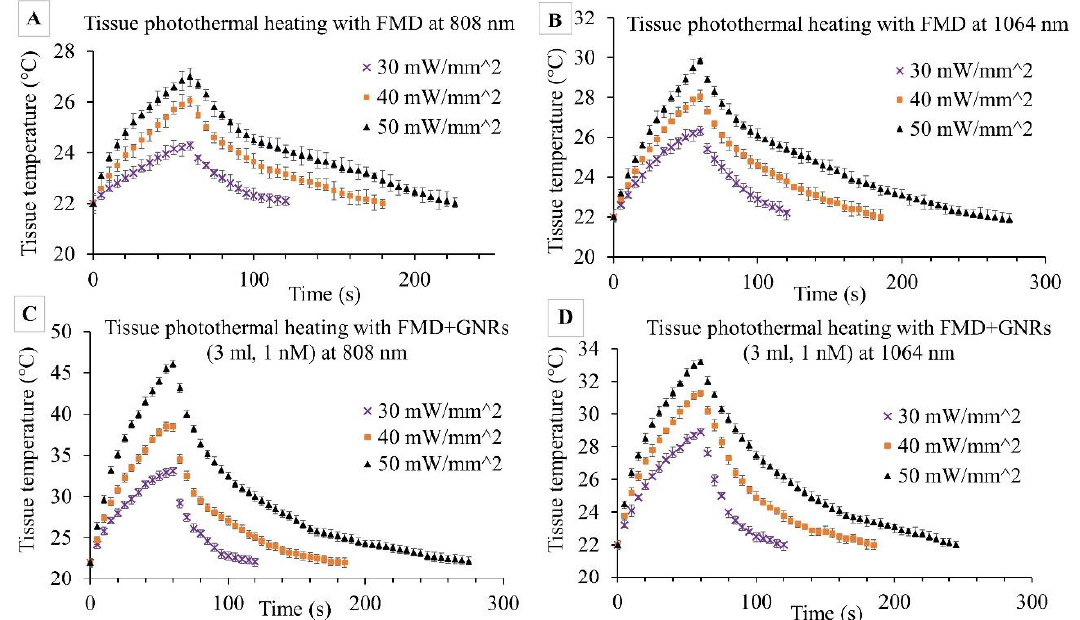
Figure 7. Ex vivo porcine pancreas tissue temperature profile during photothermal heating by FMD only without GNRs at ( A ) 808 nm, ( B ) 1064 nm; and with infused GNRs (1 nM, 1 mL) at ( C ) 808 nm, ( D ) 1064 nm wavelengths. Three different laser irradiations were tested: 30, 40, and 50 mW·mm −2 with an exposure time of 60 s followed by free convection cooling. Error bars represent mean ± 1 σ (standard deviation) for n = 5 trials. Statistical analysis (Student’s T -test) between the maximum tissue temperatures of each set of two consecutive laser irradiations for a given wavelength showed the significance of the data ( p < 0.01).